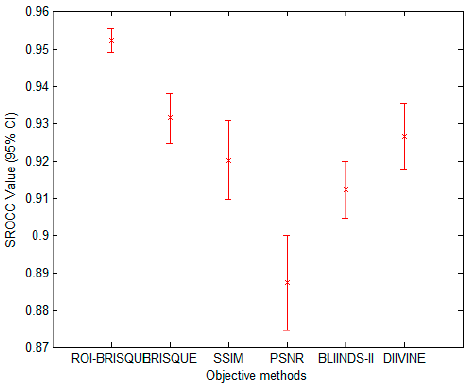
Figure 15. Mean SROCC value of the algorithms evaluated in Table 4, across 1000 train-test on the LIVE IQA database2. The error bars indicate the 95% confidence interval.